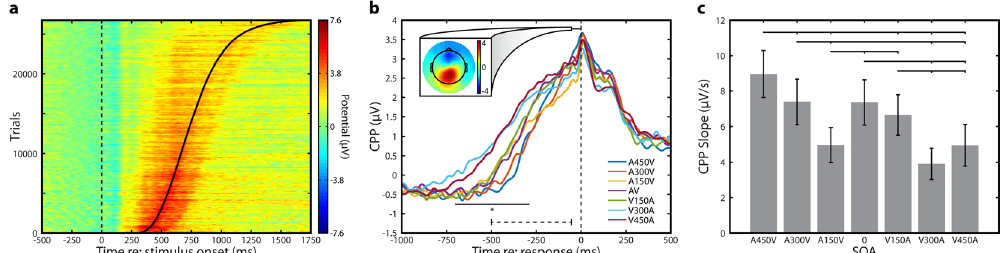
Figure 7. Decisional signal dynamics during simultaneity judgment. ( a ) Amplitude of the centro-parietal positivity (CPP) derived from single trial EEG and pooled across all 7 SOAs and all participants. The dotted line indicates stimulus onset, while the sigmoidal solid line indicates response times for individual trials. Data were sorted by response time and vertically smoothed with a 300 trial Gaussian moving average. ( b ) CPP calculated separately for each of the 7 SOAs. The dashed line at bottom indicates the time window used for slope analysis ( − 500 to − 50 ms relative to response; see panel c). Solid black line indicates time points with a significant difference in voltage (repeated measures multivariate F test at each time point; cluster p = 0.0003, randomization test). Top bar indicates the time region averaged for CPP topography ( − 50 to 0 ms relative to response), which is shown in the inset and averaged across all 7 SOAs. ( c ) Linear CPP slope for all 7 SOAs. Error bars indicate standard error of the mean. Slope was calculated in the dashed region in panel